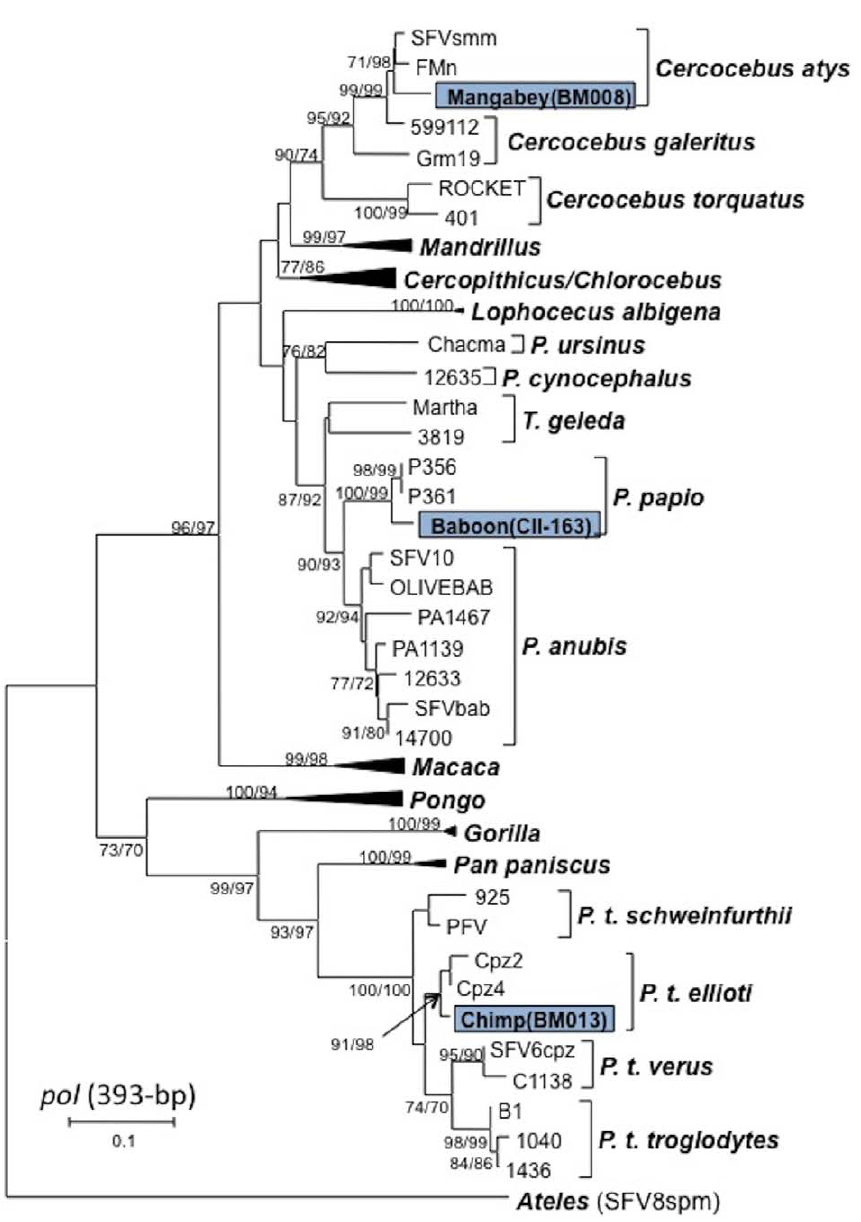
Figure 2. Inferred phylogenetic relationships of SFV pol sequences detected in bushmeat samples. Neighbor-joining (NJ) and maximum- likelihood (ML) analysis gave identical branching orders. New SFV sequences identified in this study are boxed. Clades of sequences from Mandrillus , Cercopithicus , Chlorocebus , Macaca , Pongo , Gorilla , and Pan paniscus are collapsed for presentation. Branch lengths are drawn to scale and only bootstrap values (NJ/ML) greater than 70% are